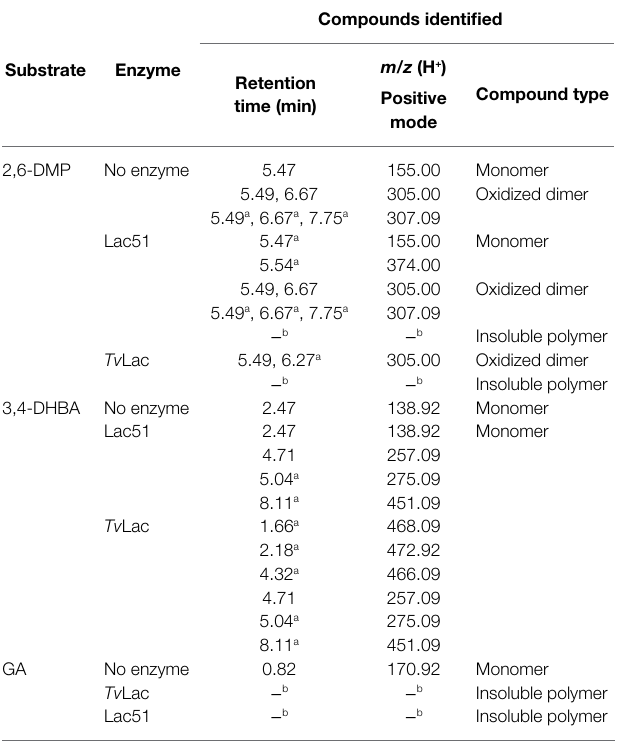
TABLE 2 | Reaction products of Lac51 and Tv Lac with lignin monomers identified with